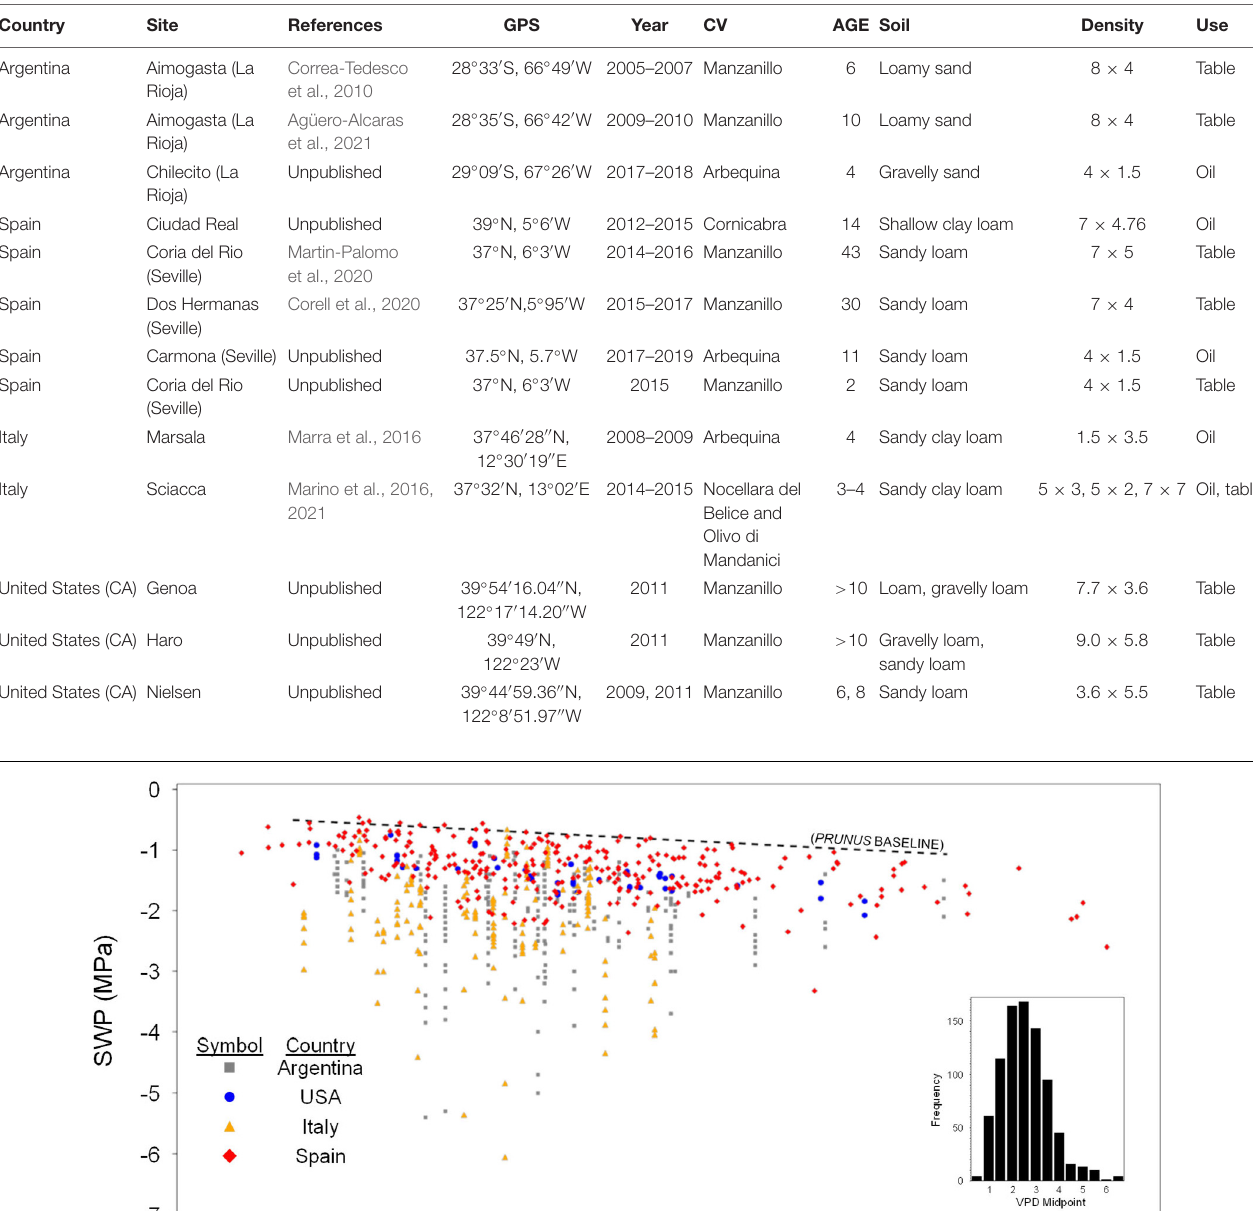
TABLE 1 | Description of the sites used in the survey. Country